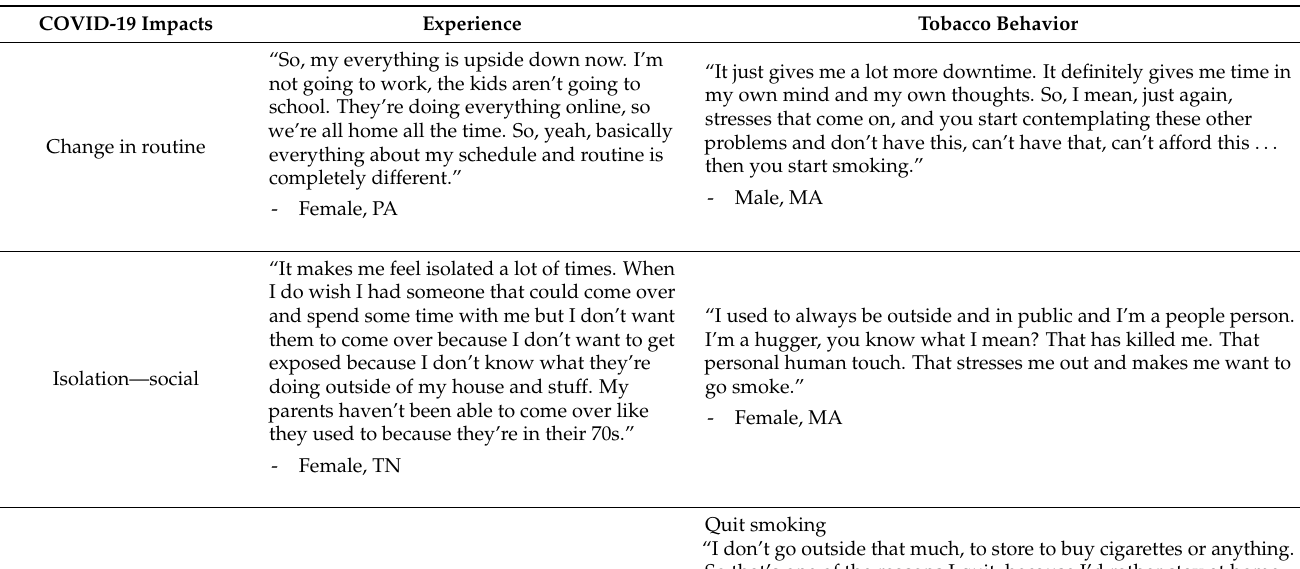
Table 1. COVID-19 impacts and reactions—participant